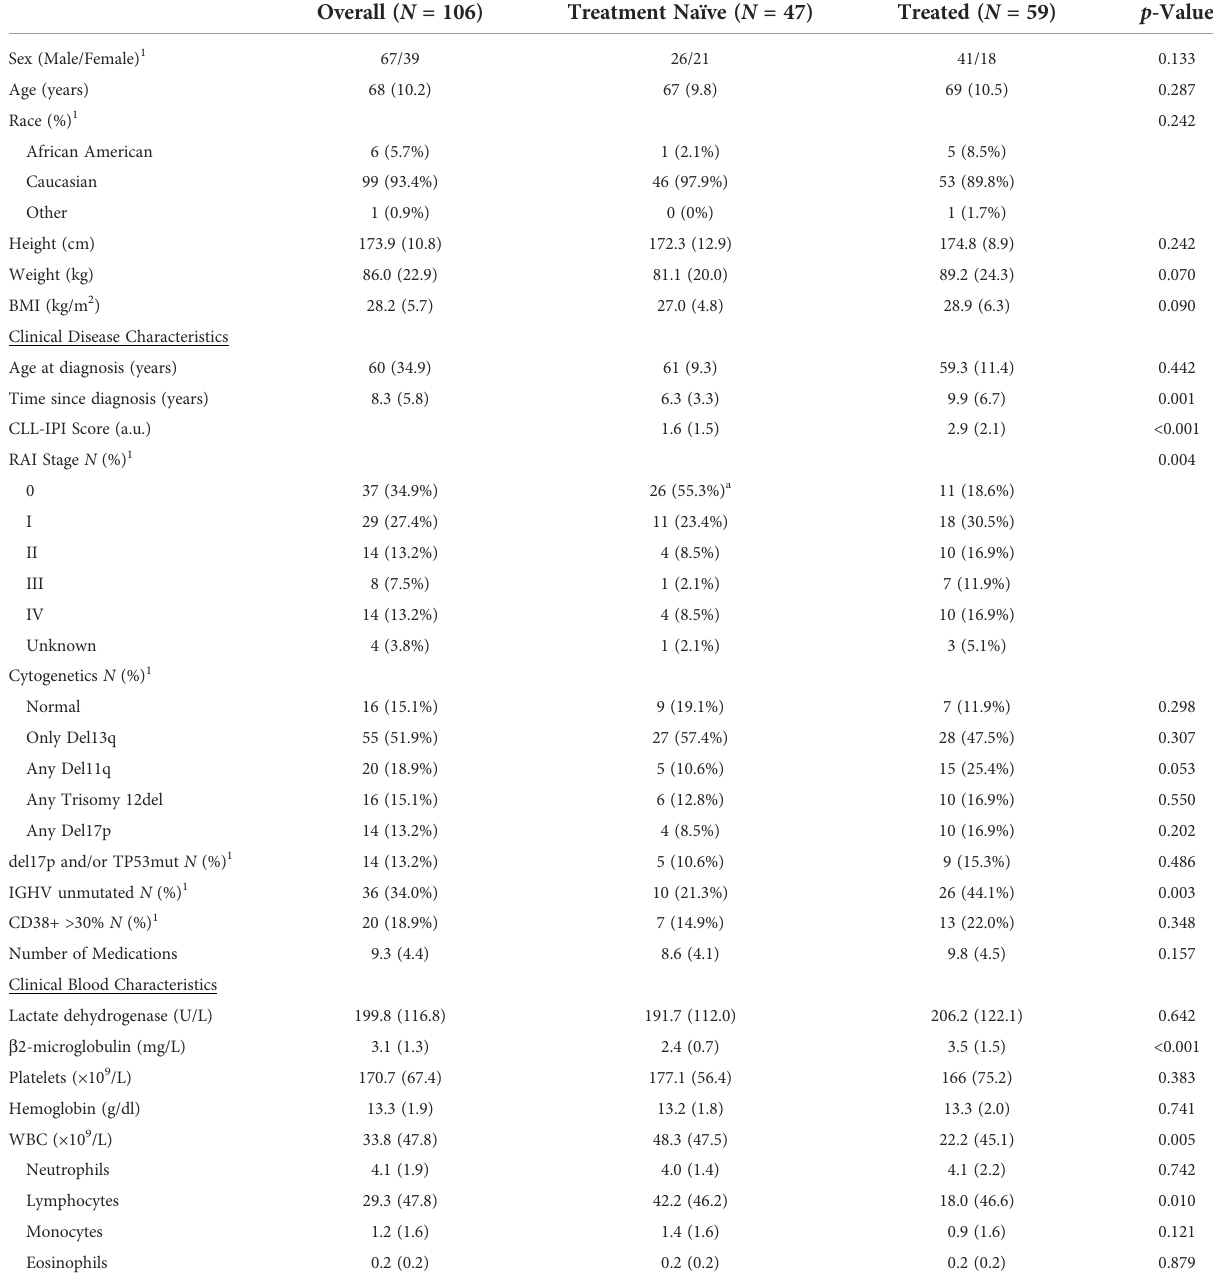
TABLE 1 Demographics and clinical characteristics of 106 patients assessed in